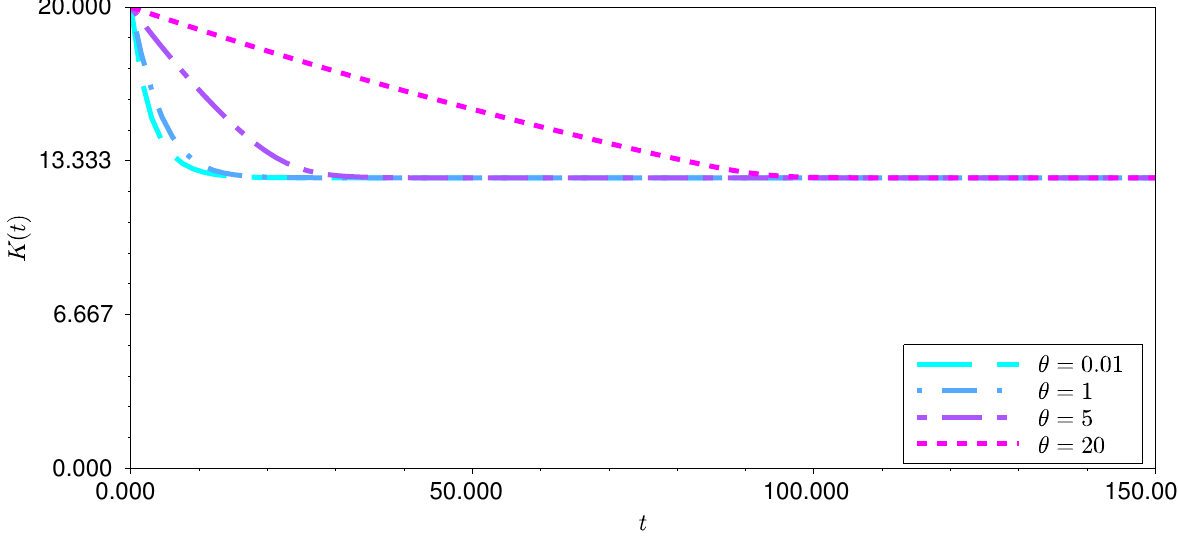
Figure 2. Profiles of K ( t ) in (13) for θ = 0.01,1,5,20 (with a = 0.2, b = 0.1, N 0 = 5 and K 0 = 20). Figure 3 ( θ = 0.01 ) and Figure 4 ( θ = 1.2 ) depict some trajectories in the NK-plane and illustrate that the carrying capacity experiences a decline as the population grows larger. This is a consequence of the proportionality of the per capita growth rates with a negative proportionality constant. Moreover, when the initial conditions are varied, the trajectories approach the equilibrium line K ∞ = N ∞ . This behaviour is typical for other values of θ as well.